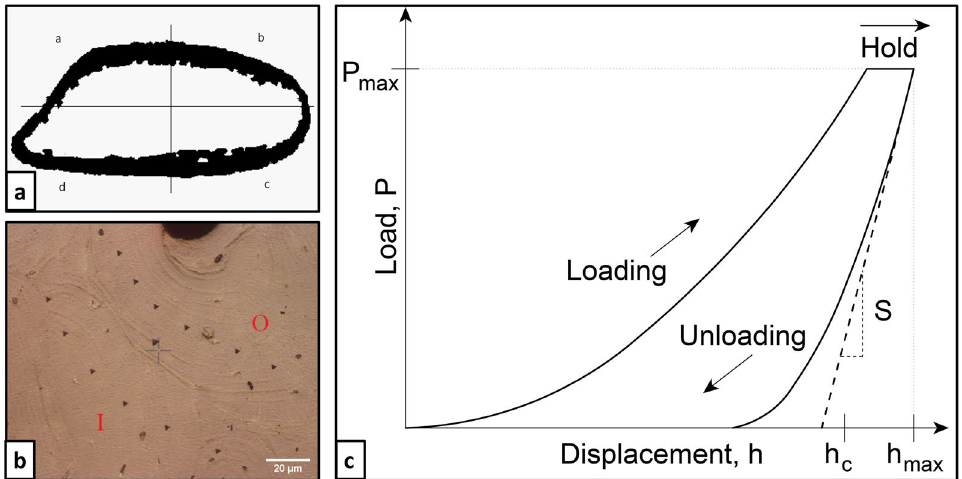
Figure 2. Steps for nanoindentation. The four quadrants used to divide the cortical area for sampling in order to perform porosity calculation ( A ) and nanoindentation impressions ( B ) on the osteon (O) and the surrounding interstitial bone (I) divided by the cement line (red dashed line). ( C ) Shows the typical load/ indentation depth curve used to acquire mechanical